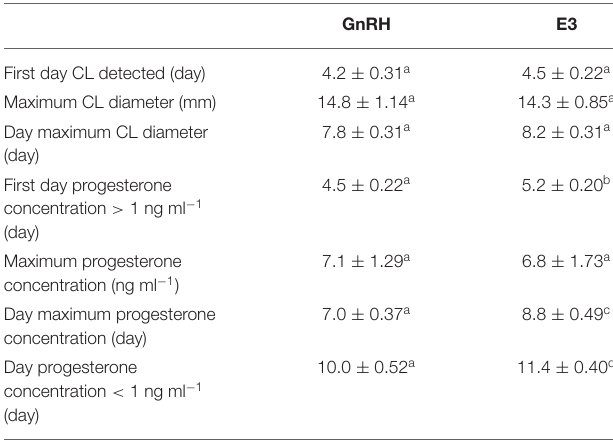
TABLE 2 | Effect of administration of GnRH and 1.6mg of estradiol-17 β (E3 group) on luteal development in llamas (mean ± SEM).